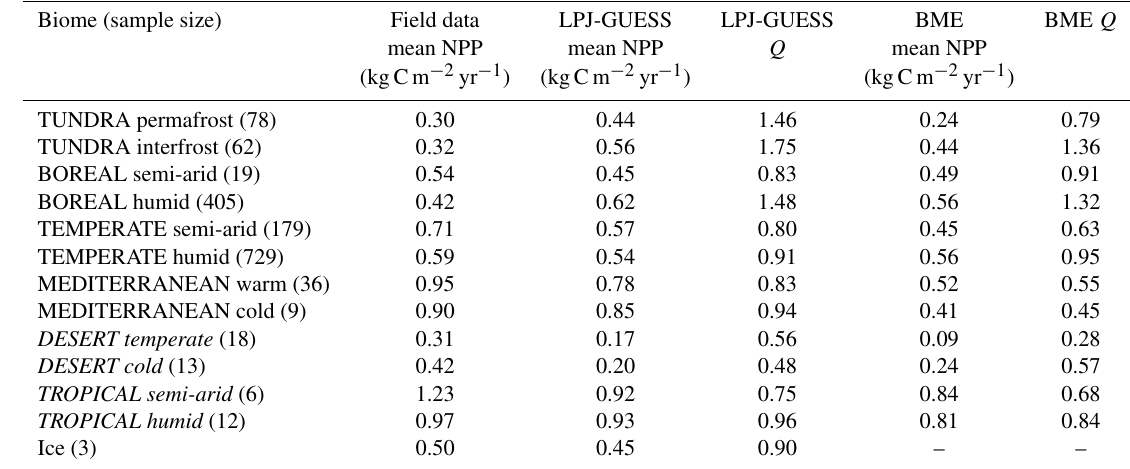
Figure A2. Comparison of LPJ-GUESS through NPP estimates and NPP field measurements at the biome level using biome mean NPP values and their standard deviation. The different colours represent MBC biomes based on Reich and Eswaran (2002). The number of NPP observations in each biome is given in the legend. Note the Sahel biomes desert temperate, tropical semi-arid, and tropical humid. Table A6. Comparison between mean biome NPP field measurements, LPJ-GUESS, BME NPP estimates, and their Q as a model perfor- mance measure. Sahel biomes are